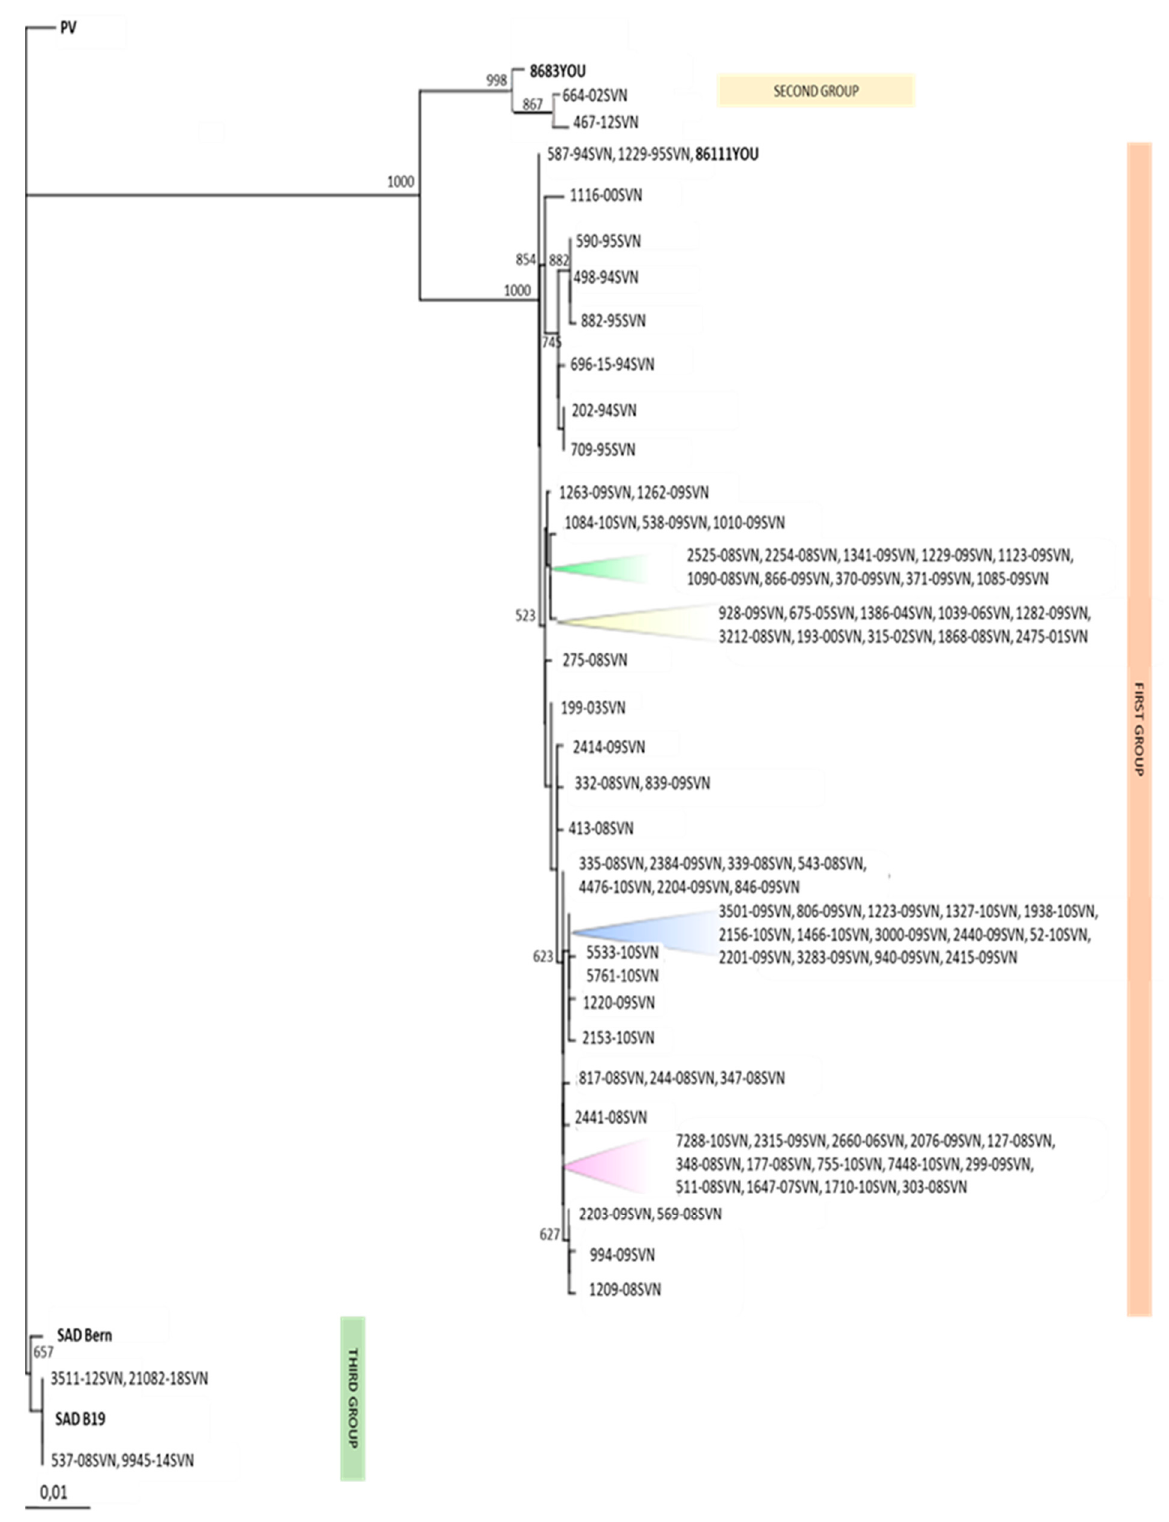
Figure 5. Phylogenetic tree based on a 1092-nucleotide sequence of the N gene of rabies virus was constructed with the Phylip program by using the maximum likelihood algorithm with strain PV (GU992322) as an outgroup. Bootstrap values were obtained for 1000 datasets. Out of 95 Slovenian sequences, 89 clustered into the first group closely related to the sequences from WE, two clustered into the second group closely related to the sequences from EE, and four clustered into the third SAD B19 vaccine-associated group.